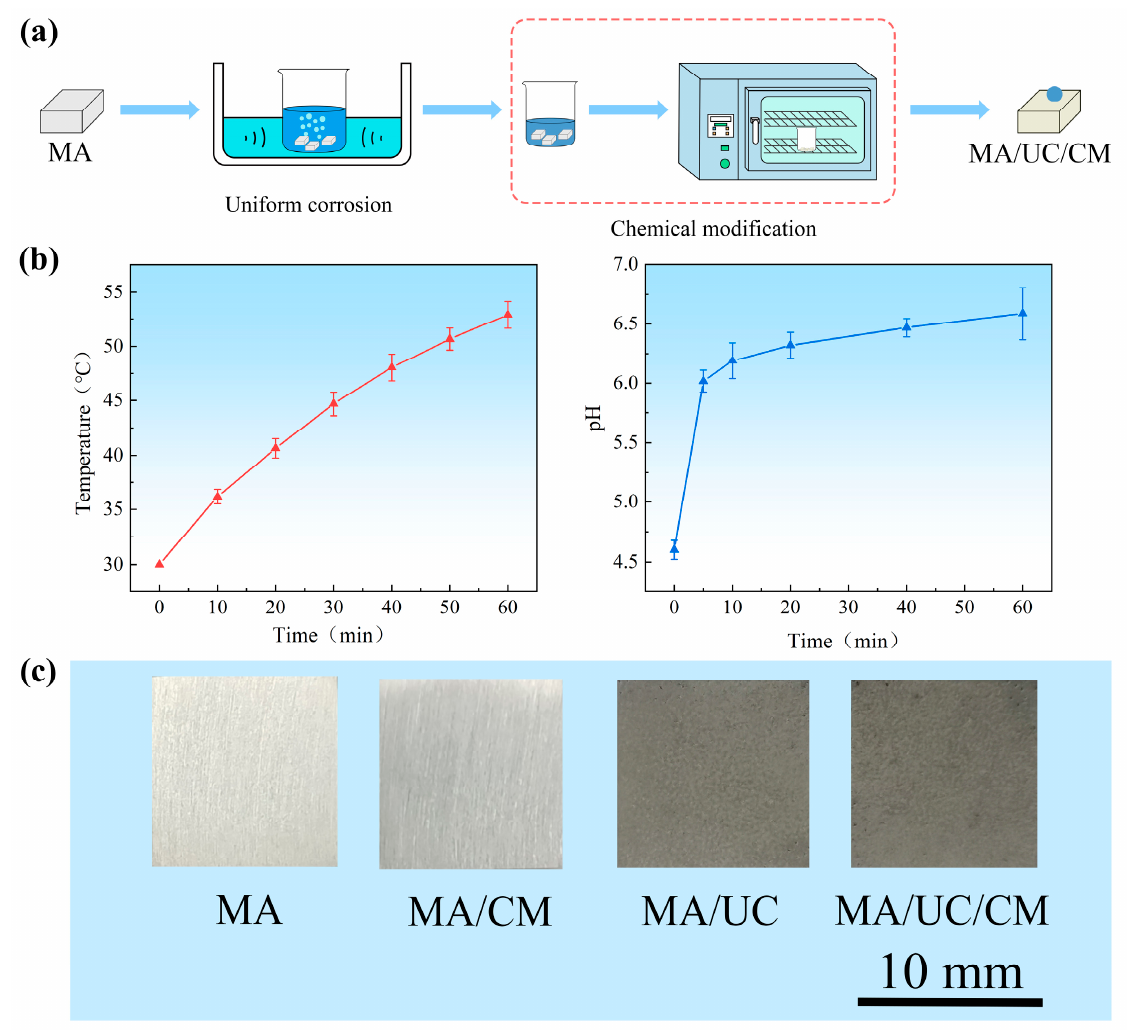
Figure 1. ( a ) Schematic diagram of the fabrication process; ( b ) temperature and pH value evolution during the process; ( c ) surface appearance of the treated and untreated samples.